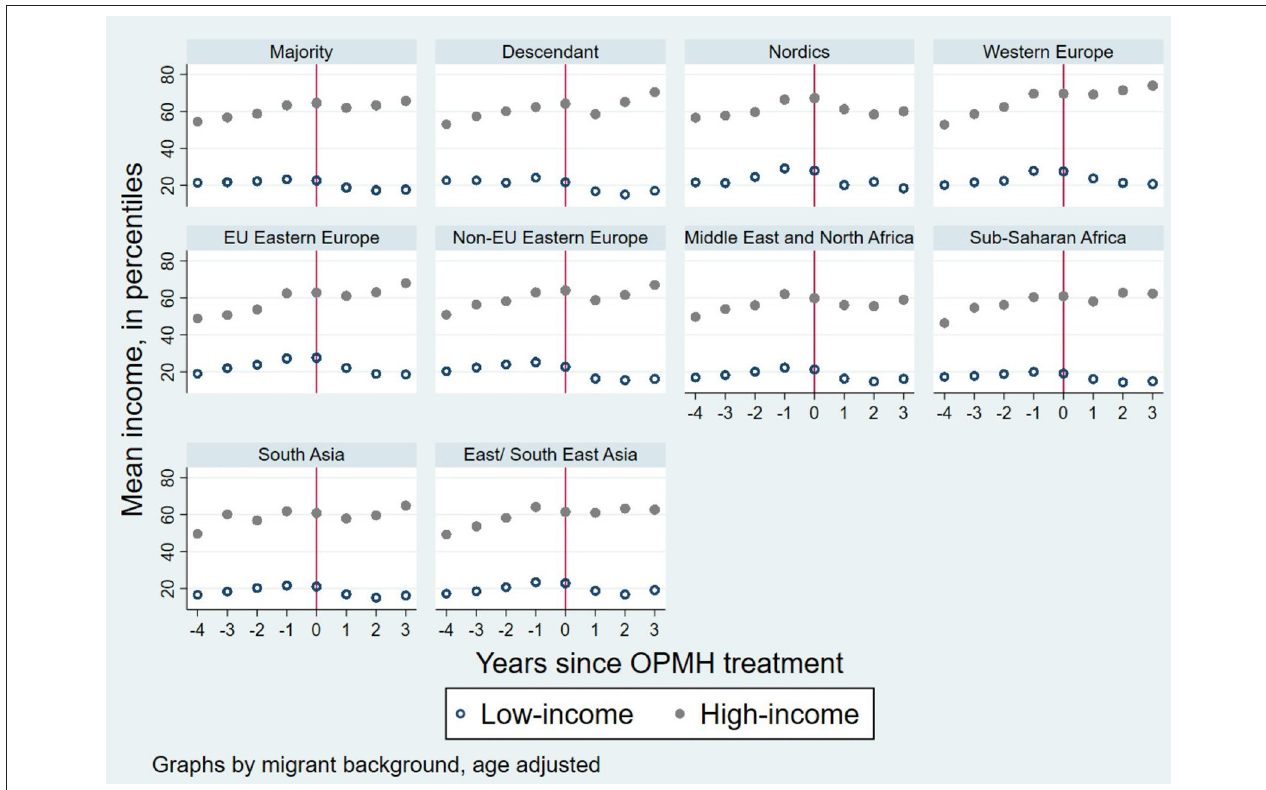
Figure 2 is a graphical presentation of the results from Table 2 , Model 2, showing the adjusted effects of OPMH treatment on income by migrant background (on the x-axis) and income group. The y-axis shows the percentile loss of